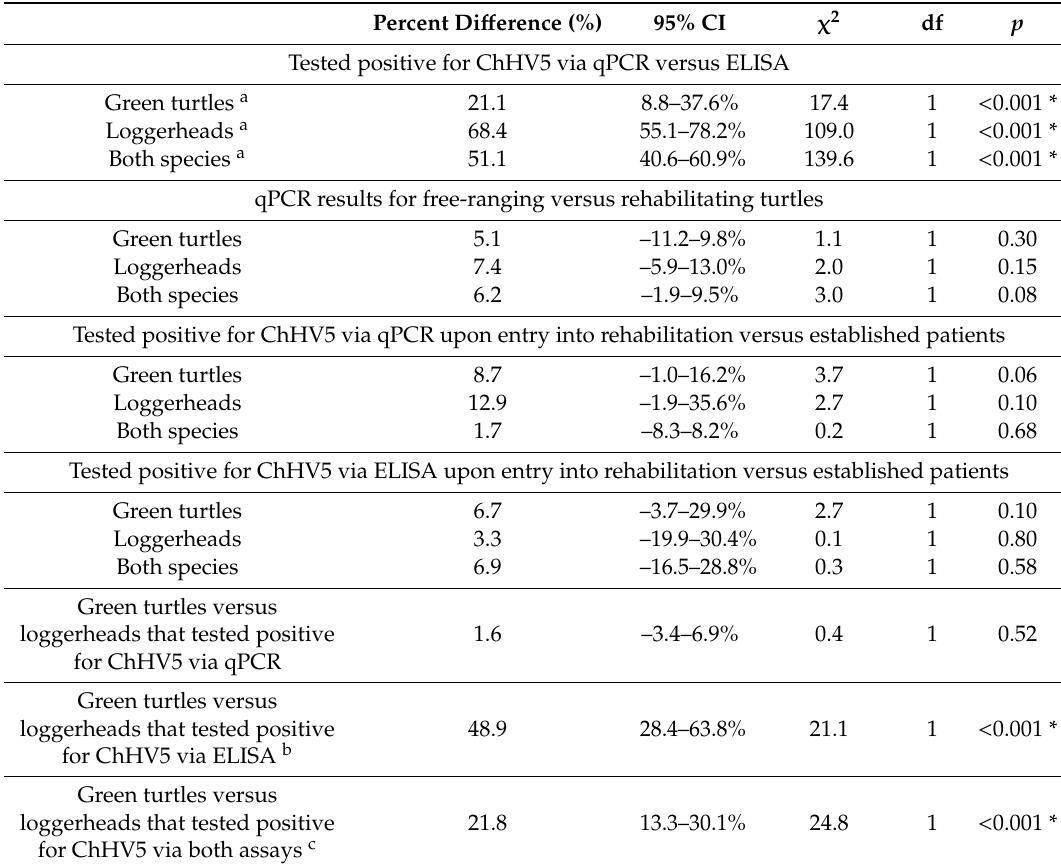
Table 3. Results of N–1 chi-squared tests to analyze di ff erences in the proportional data resulting from the two diagnostic tests included in the study, quantitative polymerase chain reaction (qPCR) and enzyme-linked immunosorbent assay (ELISA). CI, confidence interval; df, degrees of freedom; * denotes statistically significant di ff erences in proportions with α = 0.05; a Green turtles, loggerheads, and both species combined were more likely to test positive for ChHV5 via ELISA than via qPCR; b Loggerheads were more likely than green turtles to test positive for ChHV5 via ELISA; c Loggerheads were more likely than green turtles to test positive for ChHV5 via both assays combined.